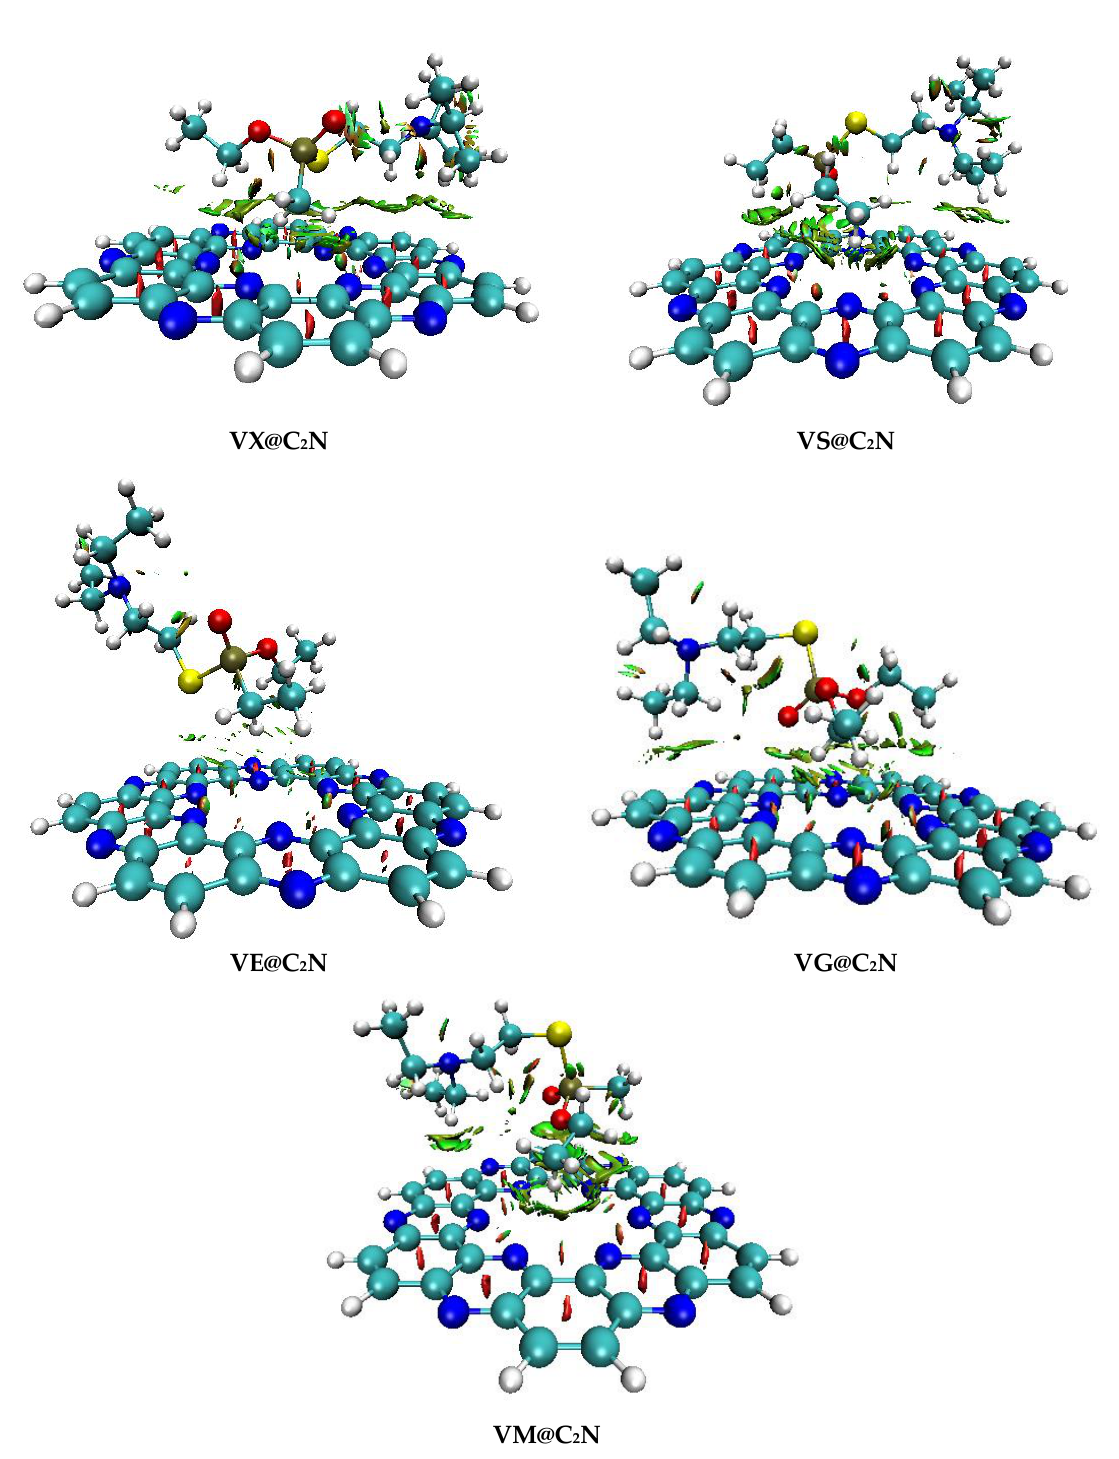
Figure 4. NCI 3D isosurfaces of optimized geometries of stable V-series@C 2 N complexes computed at M05-2X method (iso value 0.05 a.u.) here red color is for repulsive interaction, green color indicates weak van der Waal ’ s forces interactions, and blue color is for strong electrostatic interactions.